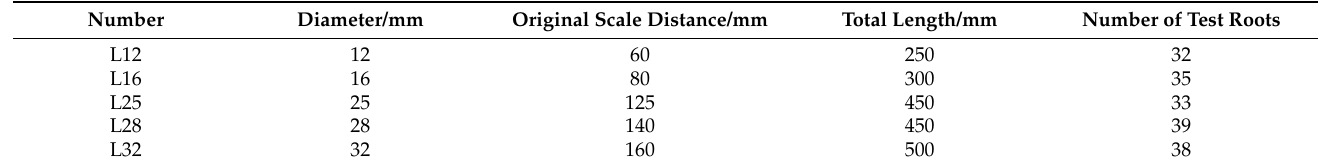
Table 2. Specimen design for room temperature tensile test of duplex stainless steel